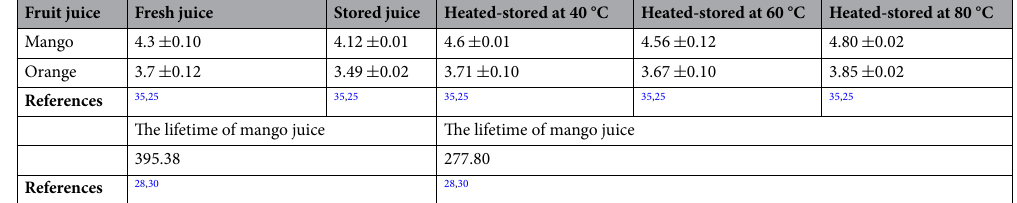
Table 3. pH value and lifetimes of mango, Orange fruit juices compared with various literature.